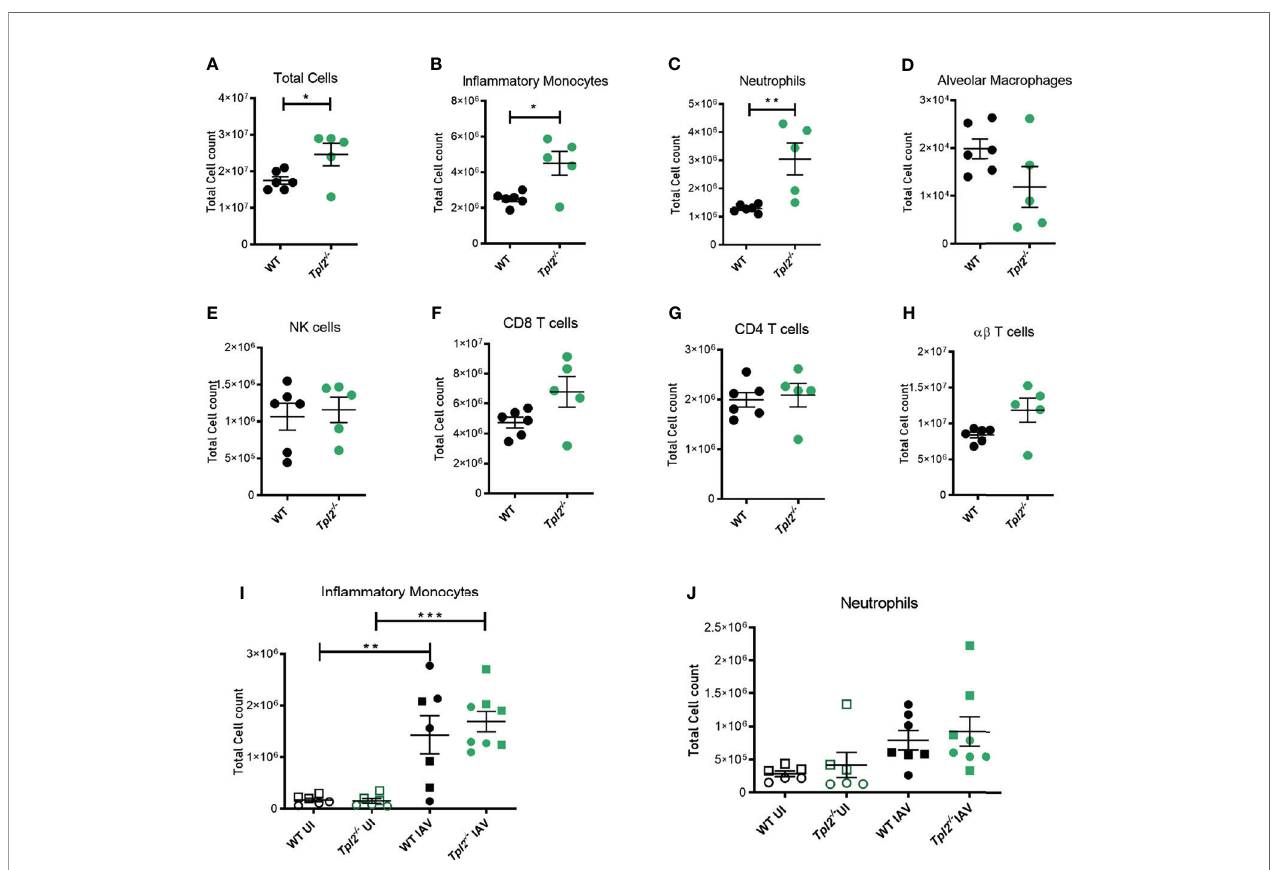
FIGURE 3 | Excessive cellular in fl ux of in fl ammatory monocytes and neutrophils in Tpl2 -/- mice infected with in fl uenza. WT and Tpl2 -/- mice were infected intranasally with 10 4 pfu of in fl uenza x31 and euthanized at 7 dpi. The lungs were lavaged, perfused with PBS, digested with collagenase, and interstitial leukocytes were enriched by Percoll density gradient centrifugation (A – H) . Cell populations of infected WT (n = 6) and Tpl2 -/- (n = 5) mouse lungs (post lavage, perfusion and digest) at 7 dpi are shown. Data are representative of 3 experiments. (I, J) In fi ltrating cell populations were also assessed for WT (n = 7) and Tpl2 -/- (n = 8) mice at 4 dpi (post lavage, perfusion and digest), including uninfected controls (UI). Data are representative of 3 experiments. Unpaired student ’ s t -test *p<0.05, **p<0.01, ***p<0.001. Squares represent male mice, and circles represent female